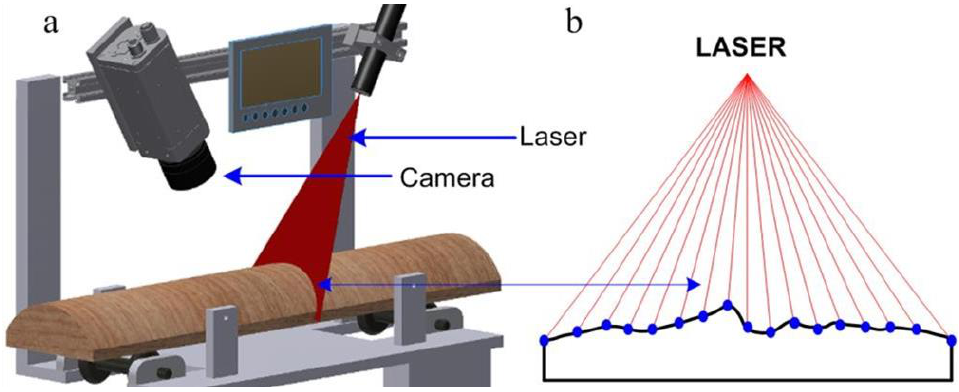
Figure 2. Framework of the measurement position. ( a ) The set-up of the video system relative to the samples tested, and ( b ) the arrangement of measurement points on the bark surface.